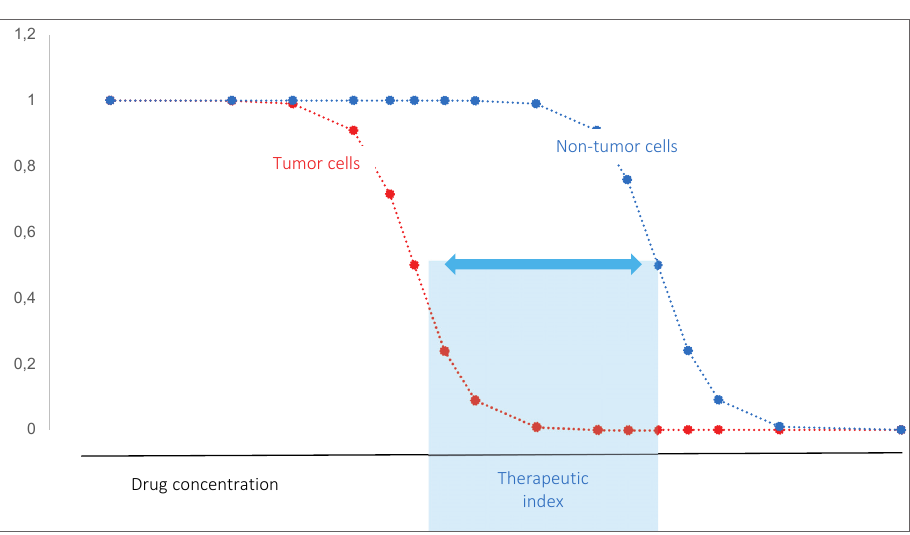
Fig. 1. Therapeutic index (blue area), the difference between two doses: one for 50% maximum effect on tumor cells and the other for 50% maximum effect on non-tumor cells.